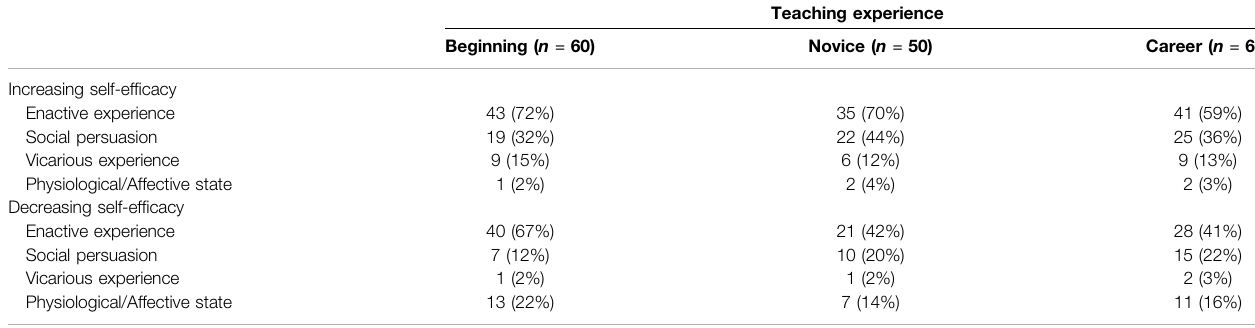
TABLE 7 | Frequency and percentage of teachers identifying sources of self-ef fi cacy by experience